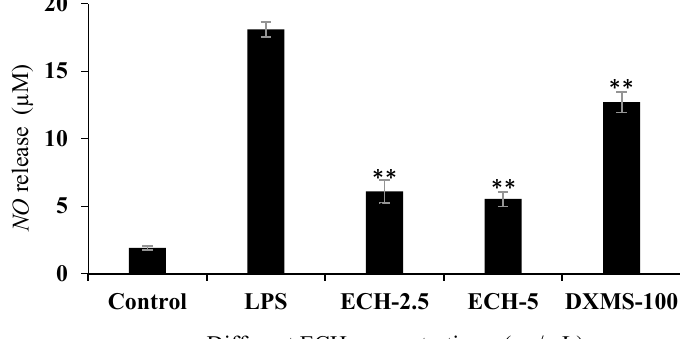
Figure 2. The e ff ects of ECH on the nitric oxide (NO) release in LPS-activated macrophages. RAW 264.7 cells were pretreated with / without indicated concentrations of ECH or dexamethasone (100 µ g / mL, positive control) for 1h then stimulated with LPS (1 µ g / mL) for 24h. NO concentrations in the cell culture medium were measured using the Griess method. ** ( p < 0.01) indicates significant di ff erence compared with the LPS group.